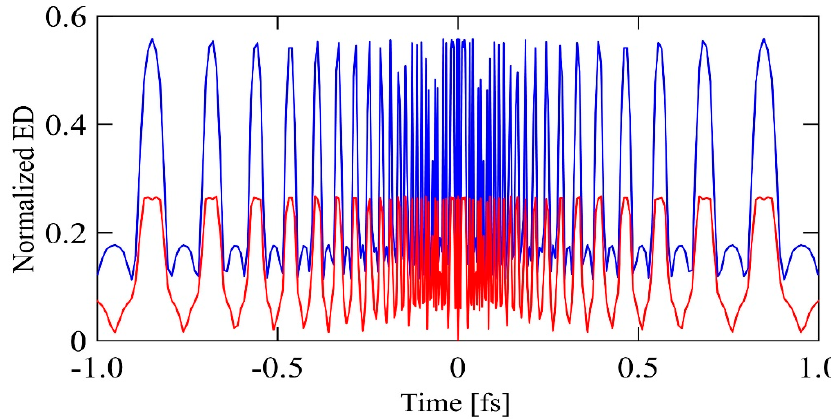
Figure 4. The plot of consciousness signals where the blue and red colors are the polaritons’ spin-up and spin-down. The full time slot of the consciousness can be detected and recorded. The gap between the spin-up and -down is the steady-state, which is the stopping state, which is no violation of the exciting environment. The two-level system is strongly confirmed when ∆ t → 0 , where a high frequency ( ∆ f → 0 ) is exhibited. The finest energy (high frequency) is achieved, which is the non-violent energy state, i.e., one continuous energy level. Table 1. The selected simulation parameters.